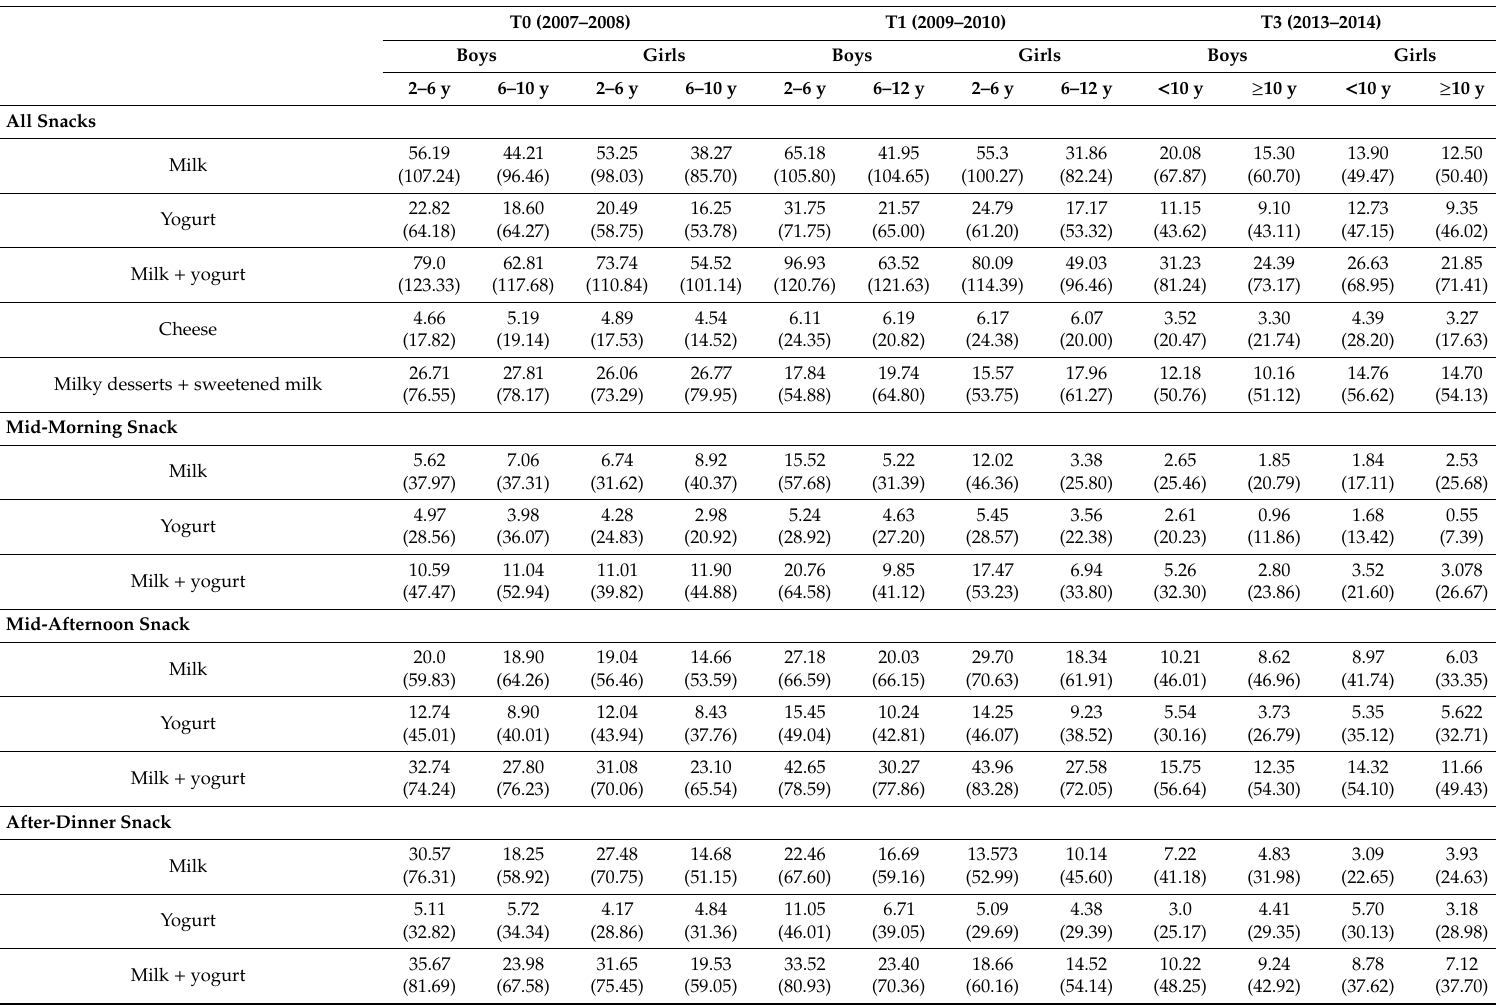
Table 3. Description of the dietary information at snack meal occasions for boys and girls in the di ff erent age categories per survey (in g / day,